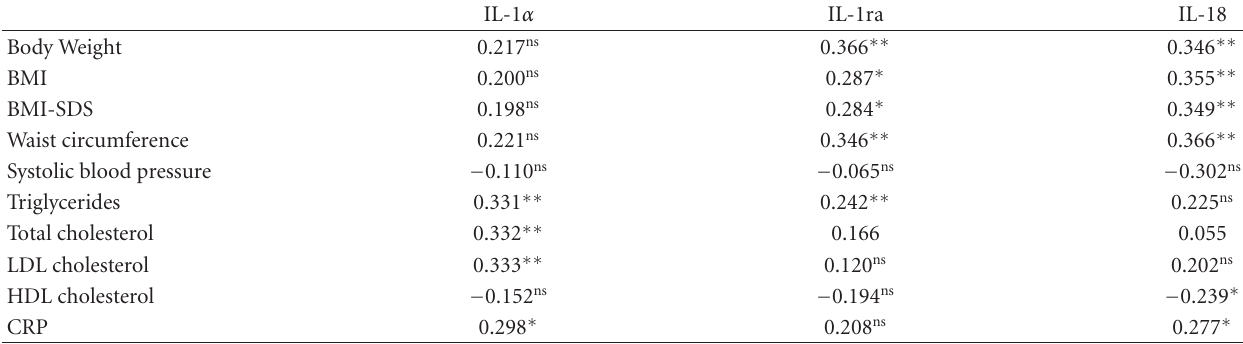
Table 2: Correlation of IL-1 α , IL-1ra, and IL-18 to anthropometrical measurements of obesity, patient characteristics, and di ff erent lab values. Indicated is the Pearson correlation coe ffi cient ( R 2